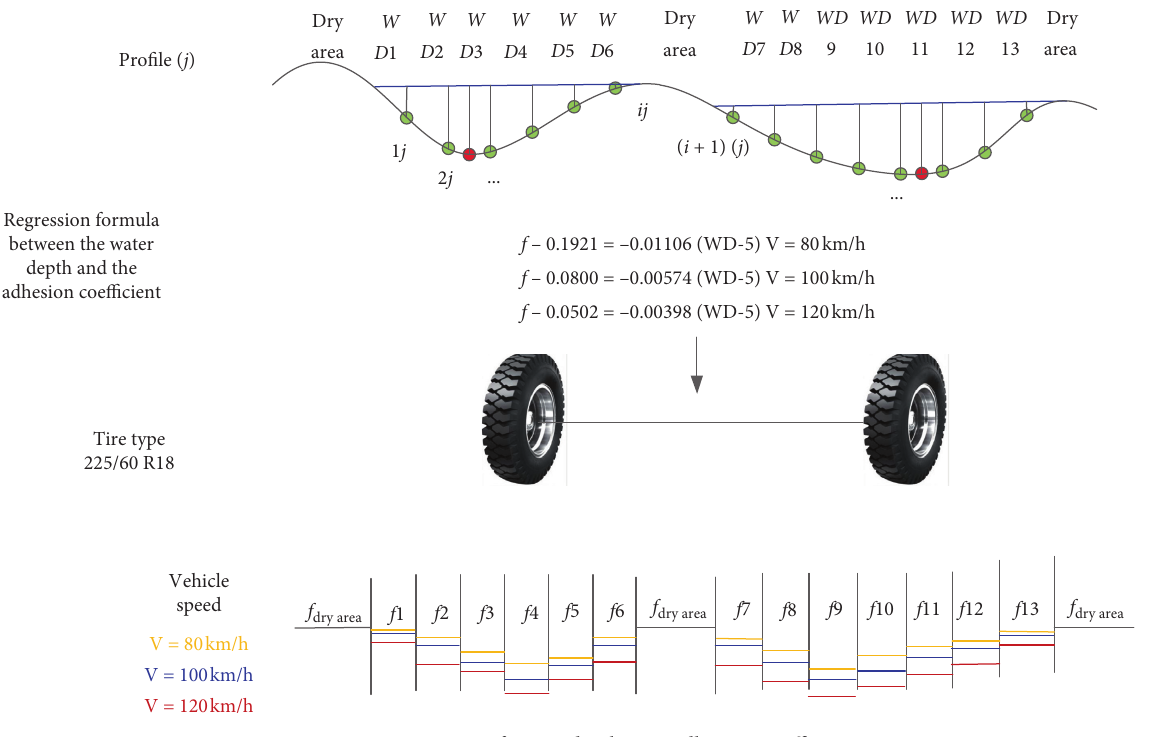
Figure 7: Conversion of water depth into adhesion